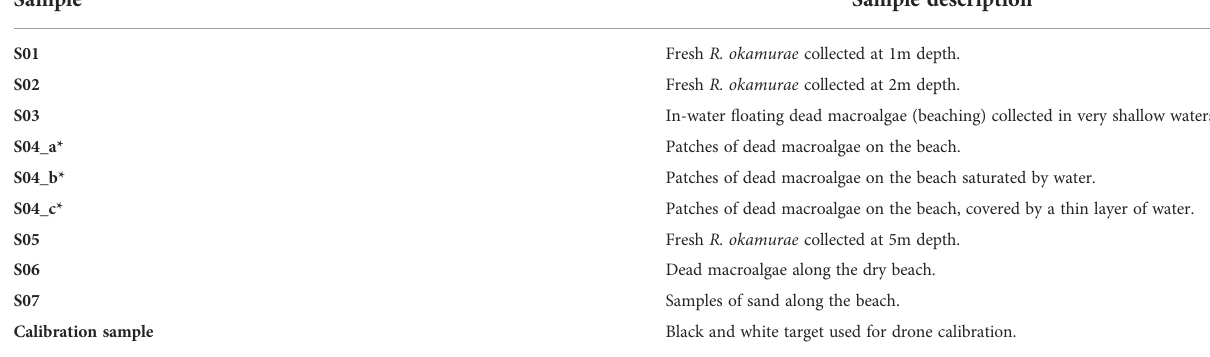
TABLE 1 Types of samples for Rugulopteryx okamurae collected in Tarifa on 1 st July 2021 for in situ spectrum.